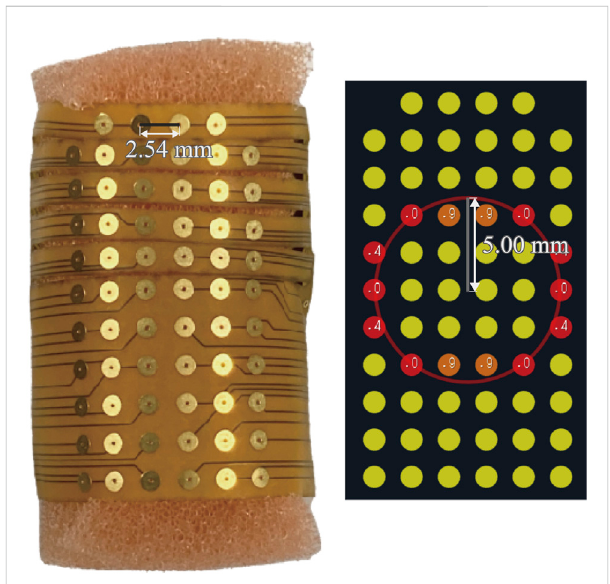
Electrodes of the electrical stimulator (left) and its schematic diagram fi tting a circle in the stimulator using a random modulator (Tirado, et al., 2020) (right). The red circle has a radius of 5.00 mm at this moment. The red- or orange-tinted electrodes are the electrodestobestimulated,accordingtoEq.1.Thecommandvalueof the stimulation intensity is constant at a preset value for all electrodes, and only the probability of stimulation varies with the distance from the